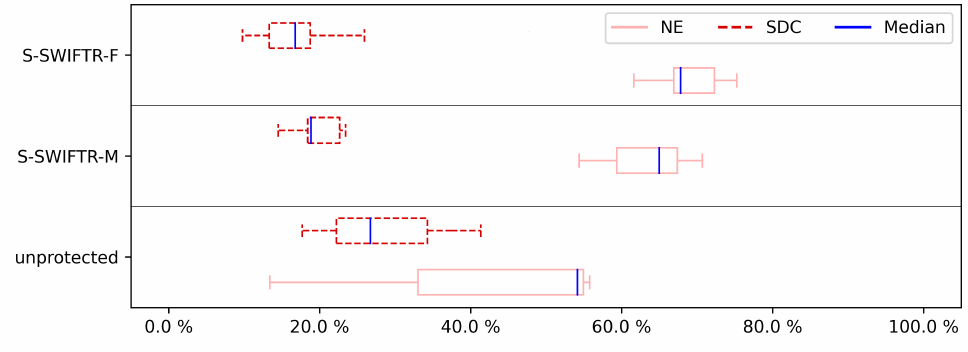
Figure 13. CFE small scale factory fault injection results for 1